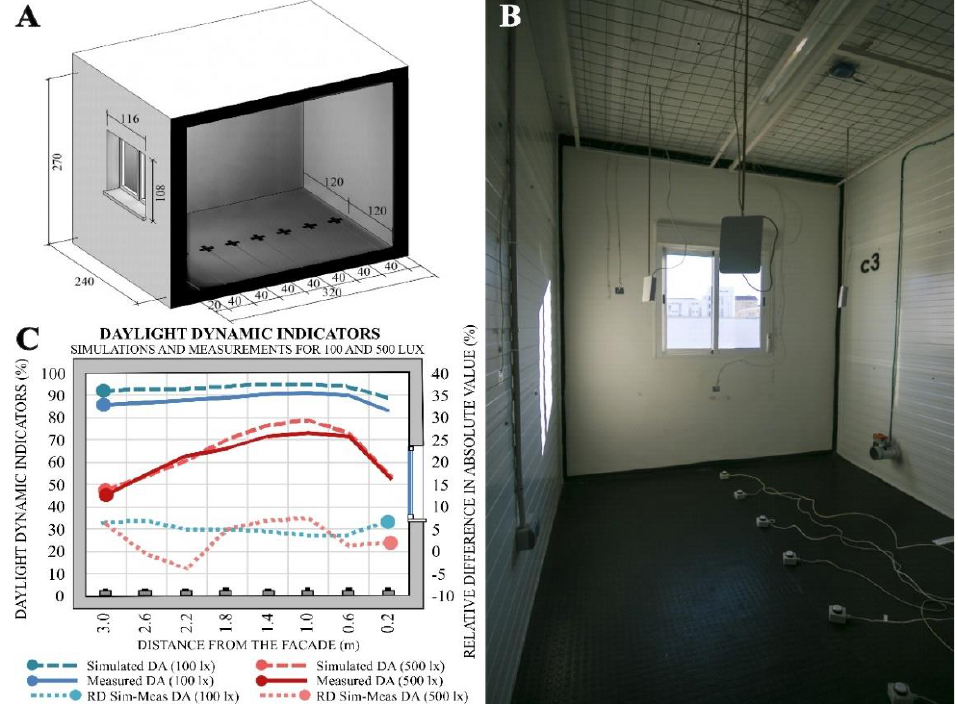
Figure 2. ( A ) Size of the test cell and distribution of illuminance-meters — ( B ) Inner view of the test cell — ( C ) DA results calculated both from illuminance measurements and simulations, including Relative Difference (RD) between them.